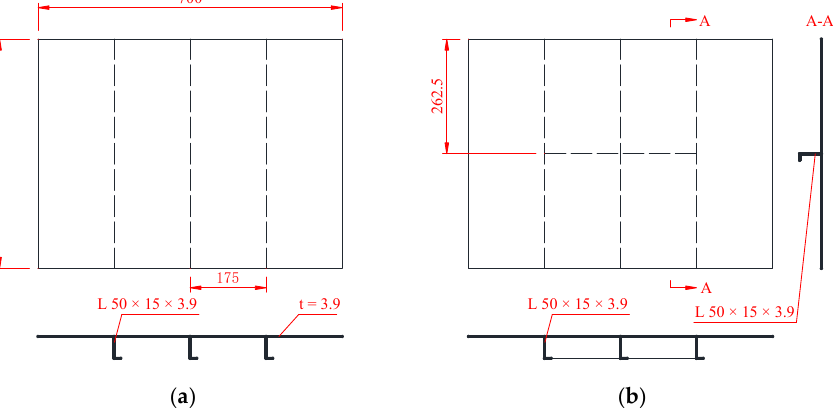
Figure 3. Geometric configurations of impact test specimens: ( a ) stiffened plate; ( b ) strengthened stiffened plate (unit: mm).